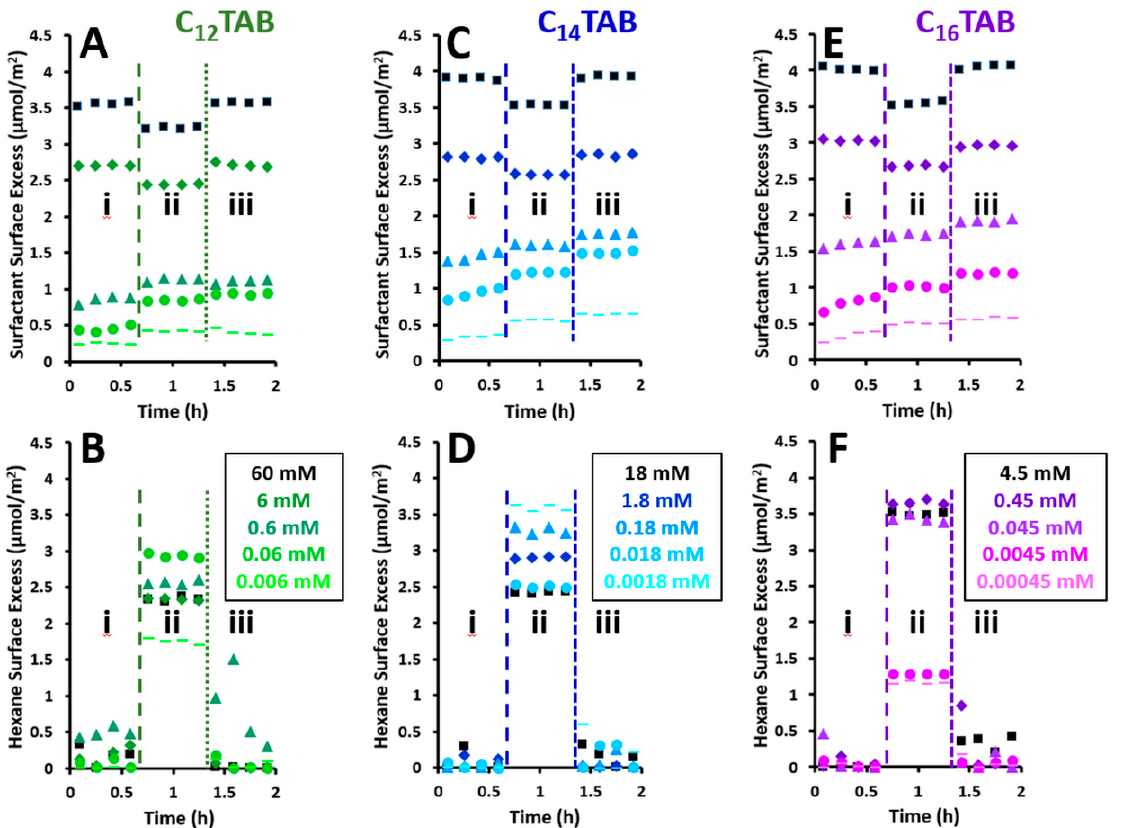
Figure 2. Surface excesses of ( A , C , E ) surfactant and ( B , C , F ) hexane from neutron reflectivity measurements involving ( A , B ) C 12 TAB, ( C , D ) C 14 TAB, and ( E , F ) C 16 TAB at the concentrations stated in the legends: (i) the first 4 data points are prior to the exposure of the adsorbed layer to hexane, (ii) the following 4 data points are the last recorded measurements representing equilibration during the interaction, and (iii) the last 4 data points are following the venting of the hexane from the sample changer by removing the sealed lids.